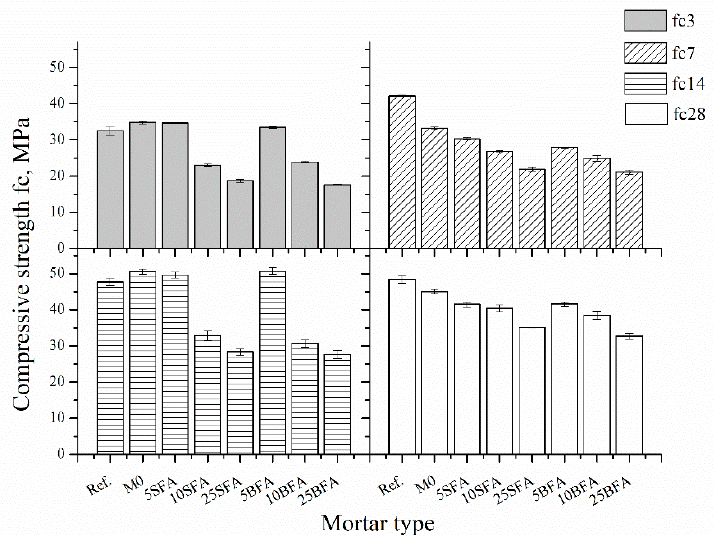
Figure 4. Compressive strength of tested mortars.